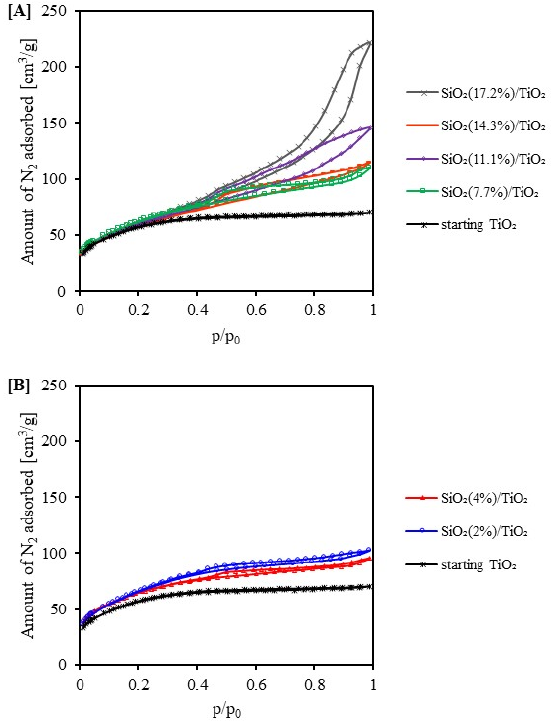
Figure 3. Adsorption–desorption isotherms of: ( A ) starting TiO 2 , SiO 2 (2%)/TiO 2 and SiO 2 (4%)/TiO 2 ,